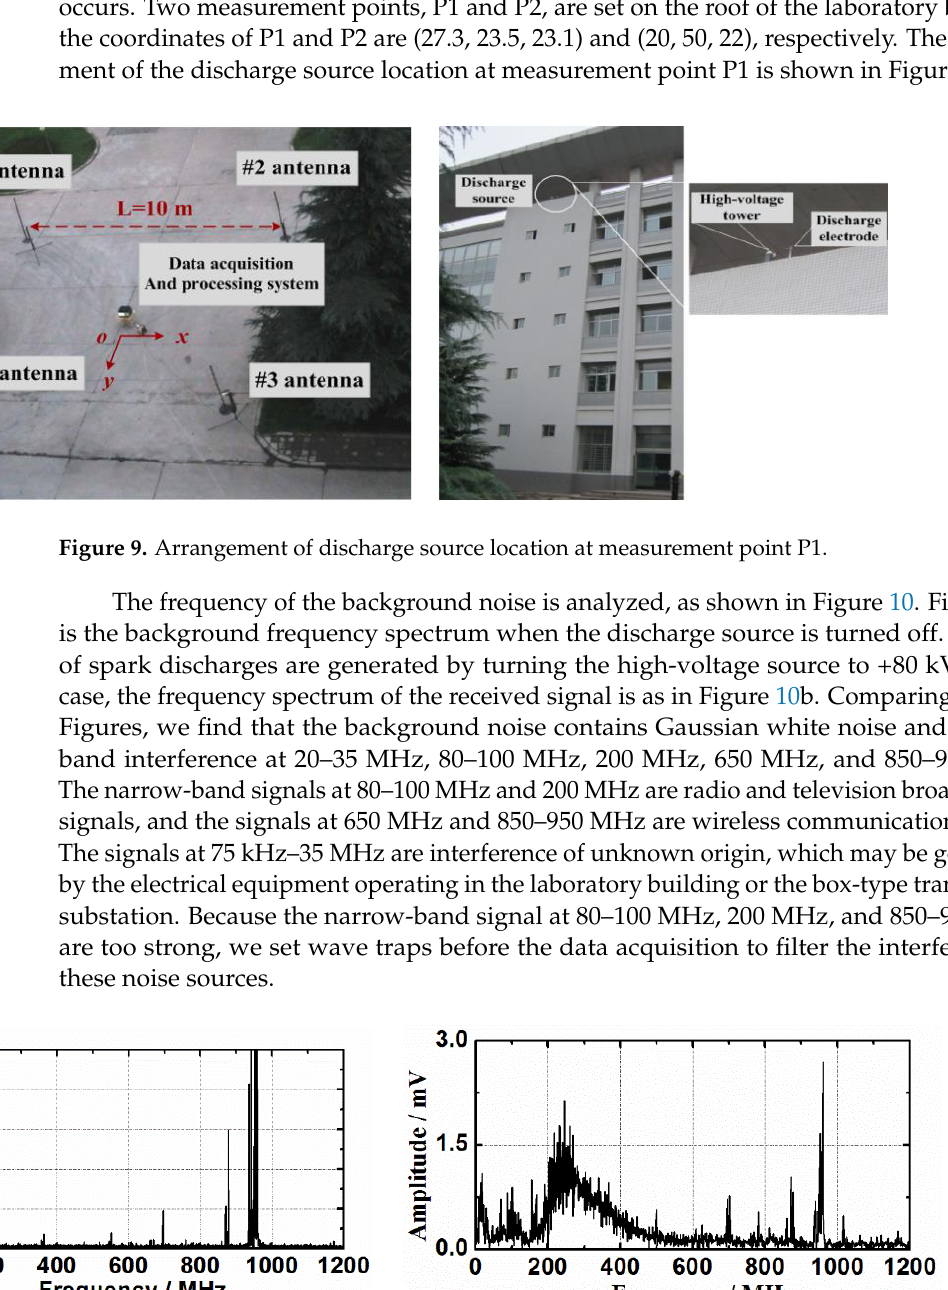
Figure 8. Experimental setup. #1 – #4 are the antennas #1 – #4.